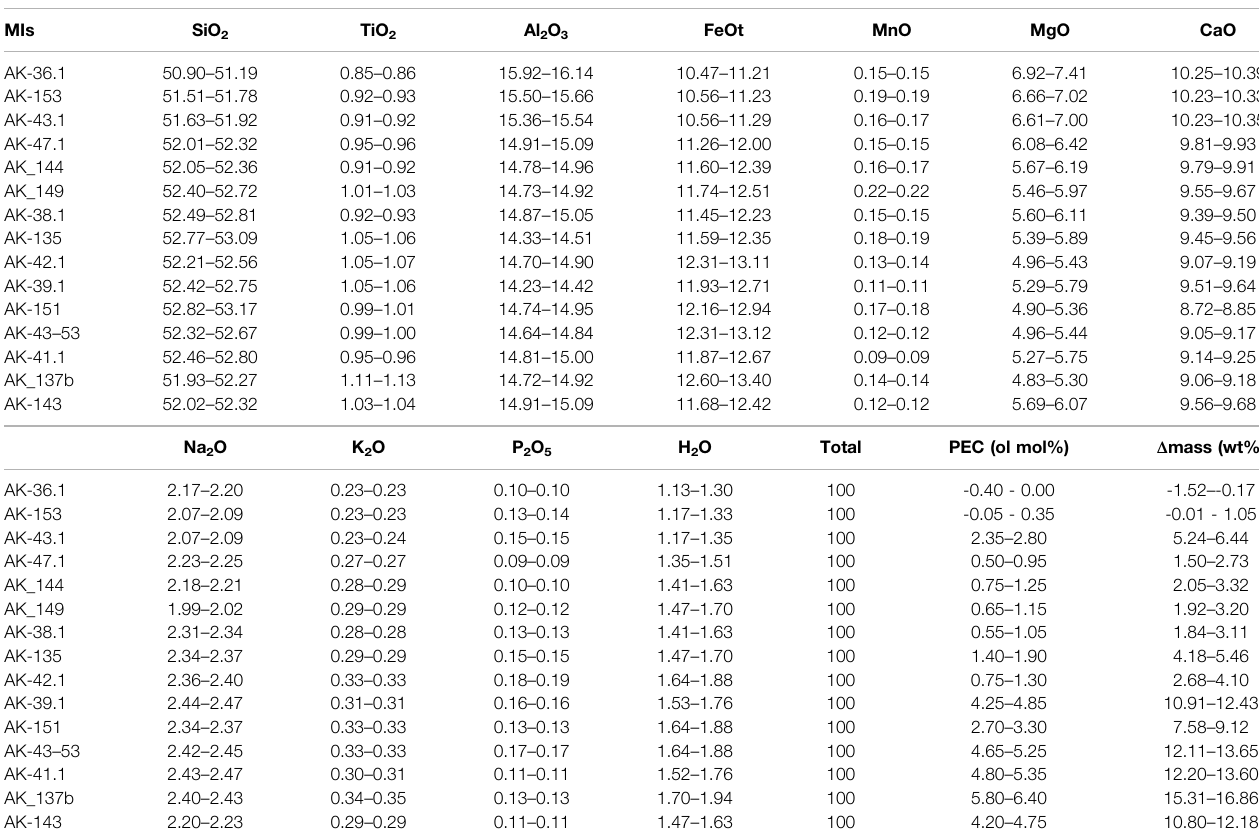
TABLE 4 | Compositional range of corrected MIs from AK using the MushPEC algorithm. MIs SiO 2 TiO